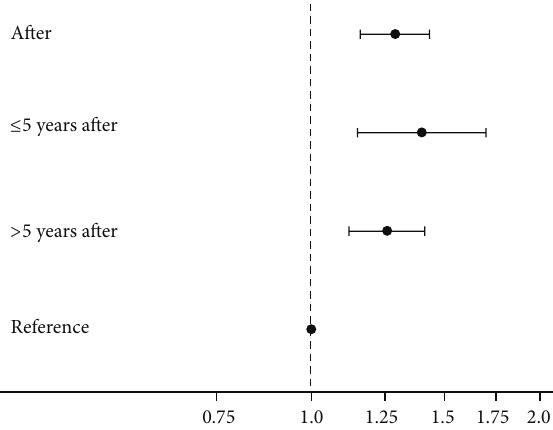
Figure 4: Adjusted hazard ratio with 95% confidence interval for risk of epilepsy in singletons exposed to maternal hyper- or hypothyroidism firsttimediagnosed before orafter birthof thechild and registered in the Danish National Hospital Register (DNHR) beforeJanuary1,2007.Referenceischildrenborntomotherswithno diagnosis of hyper- or hypothyroidism registered in DNHR before January 1, 2007. Model included gender of the child (boy/girl), birth year ( < 1980, 1980–1982, 1983–1985, 1986–1988, 1989–1991, following maternal variables obtained at the time of the child’s birth: age ( < 20, 20–24, 25–29, 30–34, 35–39, ≥ 40 years), parity including index pregnancy (1, 2, 3, ≥ 4), cohabitation (married/not married), income (1st, 2nd, 3rd, 4th quartile), origin (born in Denmark/not born in Denmark), residence (East/West Denmark), and maternal diagnosis of febrile seizure and/or epilepsy registered in the Danish National Hospital Register (DNHR) before January 1, 2007 (yes/no).